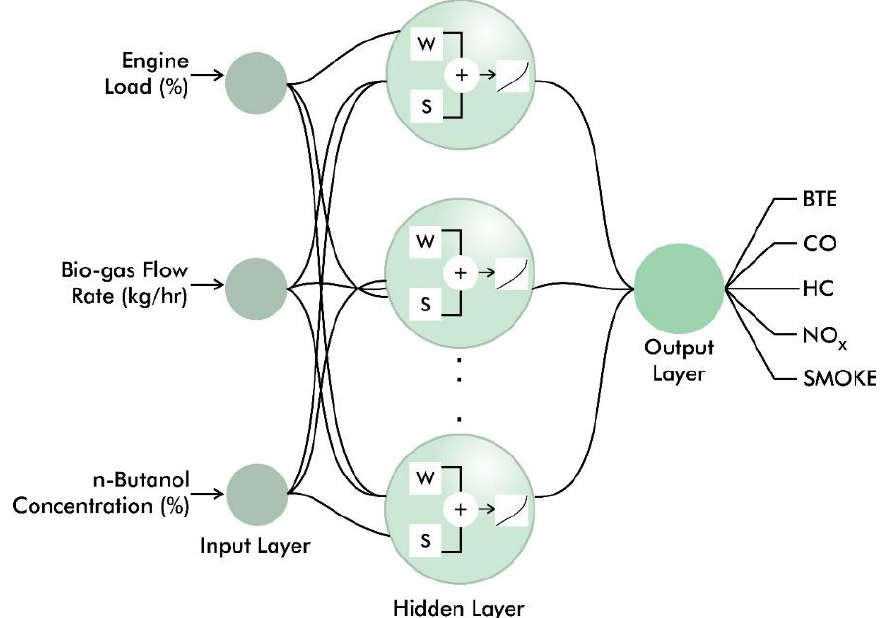
Figure 2. Structure of ANN model. Table 4. Details related to the NN model used in this research.